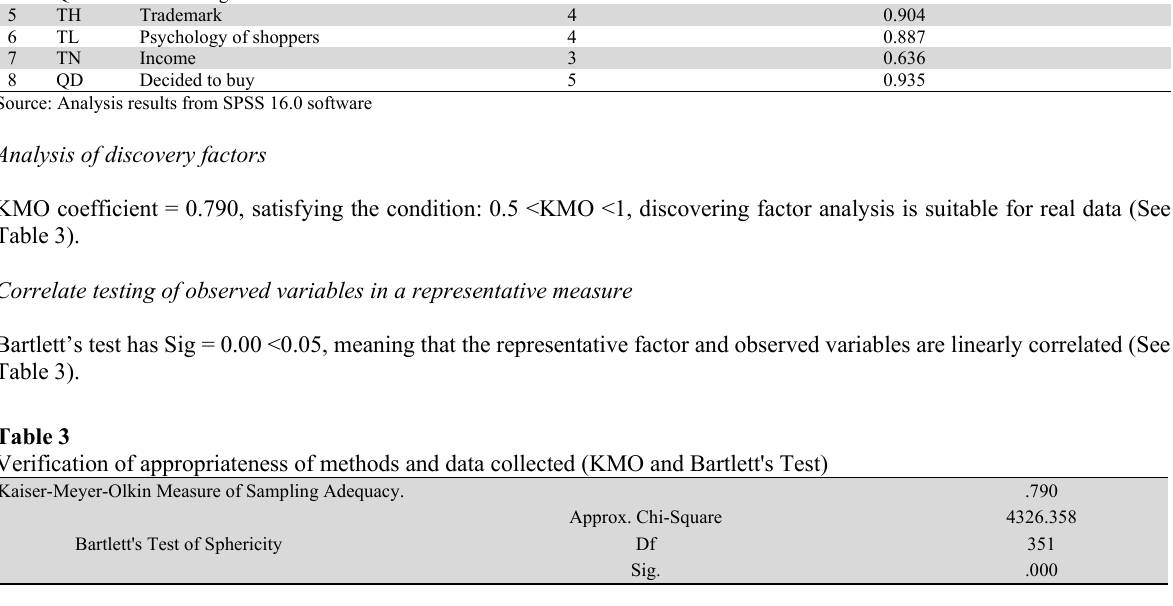
Verification of appropriateness of methods and data collected (KMO and Bartlett's Test) Kaiser-Meyer-Olkin Measure of Sampling Adequacy.